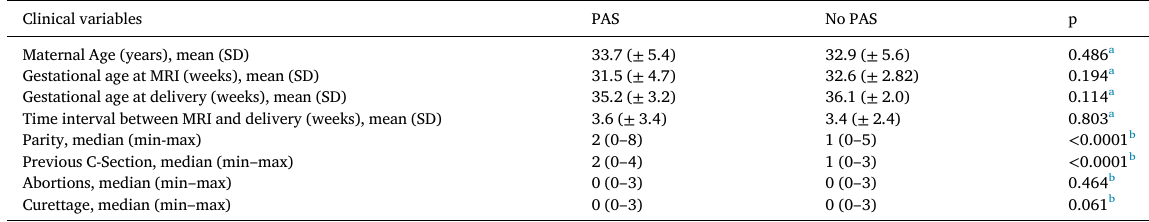
Table 2 Analyses of clinical data and association with placental acretism.